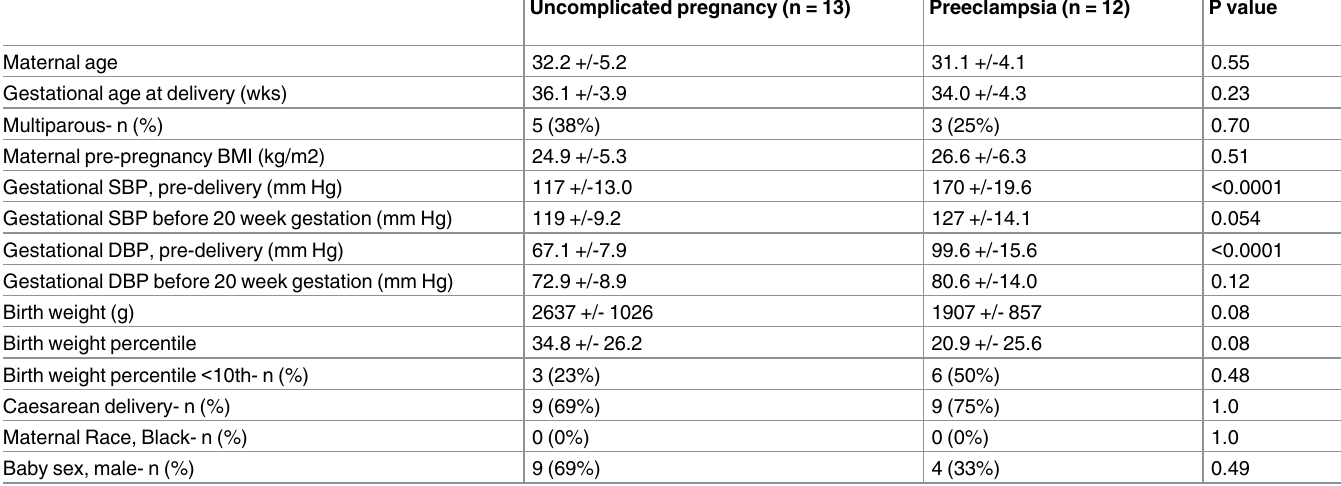
Table 1. Clinical and demographic data of patients who provided maternal blood samples (data are mean +/-